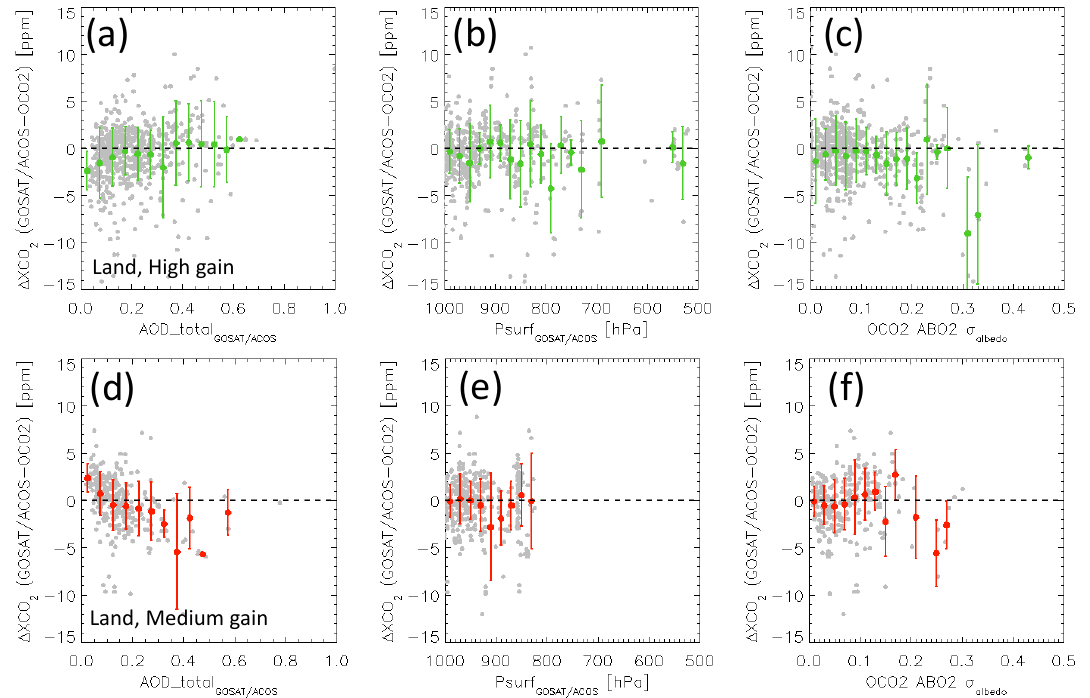
Figure 9. ∆XCO 2 as a function of ( a ) GOSAT/ACOS retrieved AOD at 0.755 µm; ( b ) GOSAT/ACOS retrieved surface pressure and ( c ) OCO-2 ABO2 σ albedo over land with high gain. The lower panels ( d – f ) show same parameters as the above panels over land with medium gain. All match-up data were plotted with gray marks. The green and red plots and bars are the average value and standard deviation within each bin. The bin sizes are ( a ) 0.05; ( b ) 20 hPa and ( c ) 0.02. The upper panel shows over land with high gain and the lower panel shows medium gain.